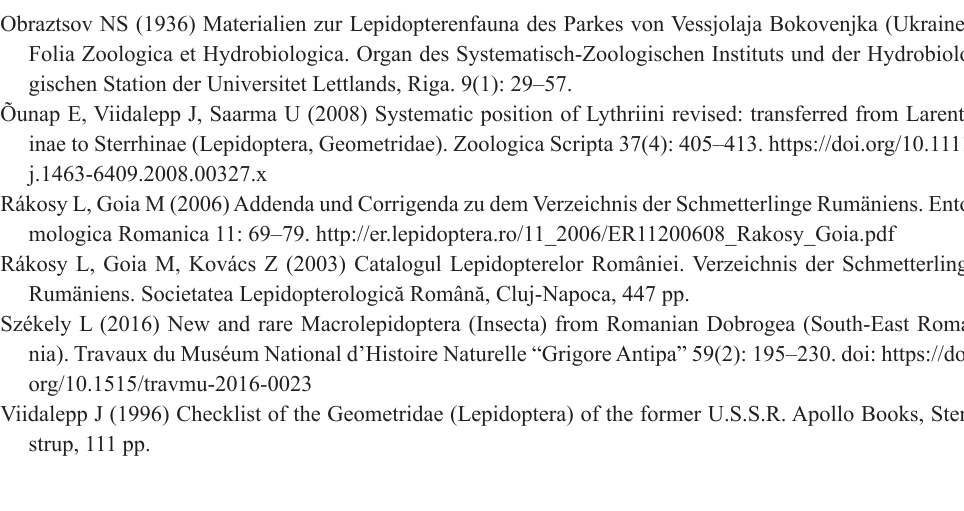
Table S1. Specimens and DNA sequences used in this study Authors: Vlad Dincă, Levente